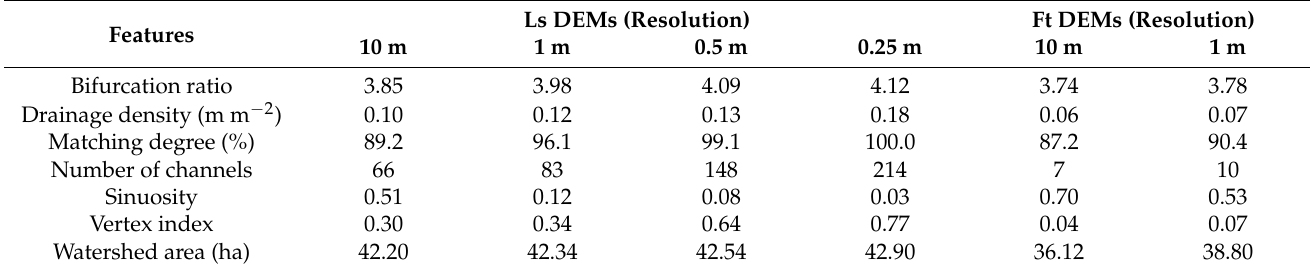
Table 2. Morphometric features for the LIDAR (Ls) and photogrammetric (Ft)